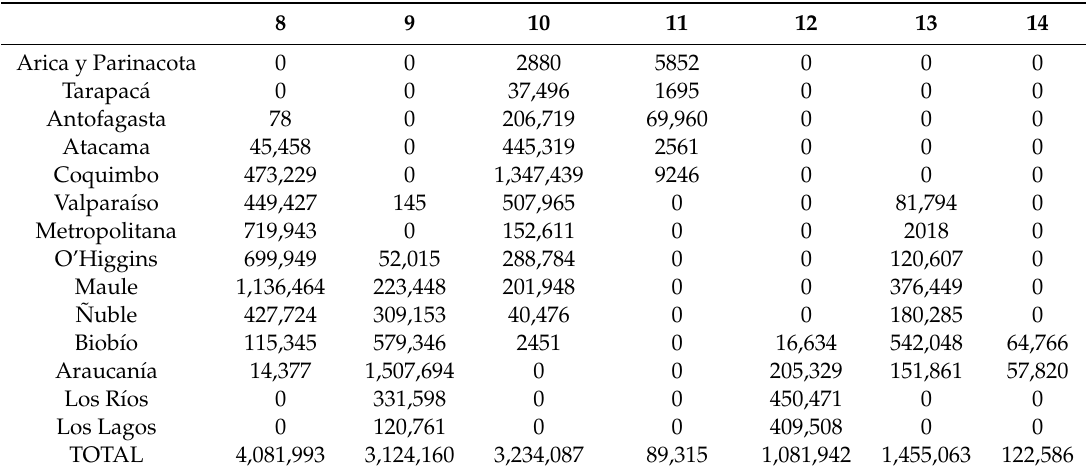
Table 4. Regional surface area with climatic aptitude for castor bean production as a national oil-seed crop (ha), according to the presence-species methodology. Chilean total area: 75.29 million